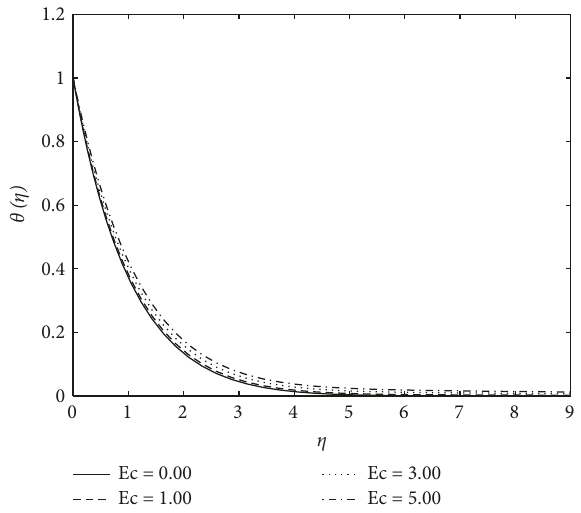
Figure 10: Change in the value of θ ( η ) for different values of Ec.